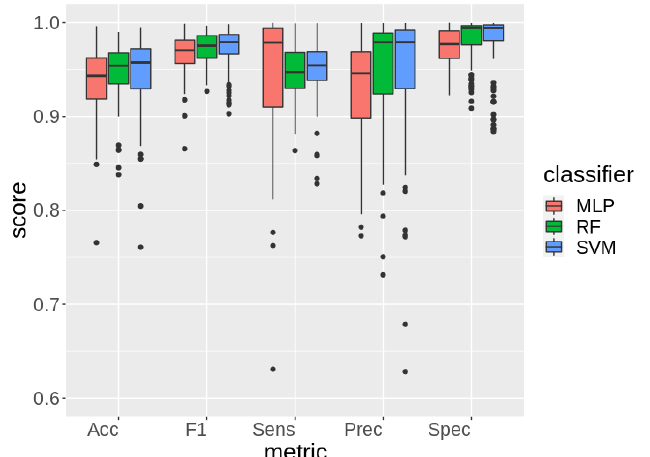
Figure 2. Performance estimation in terms of each metric, on cross validation, of Multilayer Perceptrons (MLP), Random Forest (RF) and Support Vector Machines (SVM) trained with 10 5 randomly sampled pixel for cloud detection task.